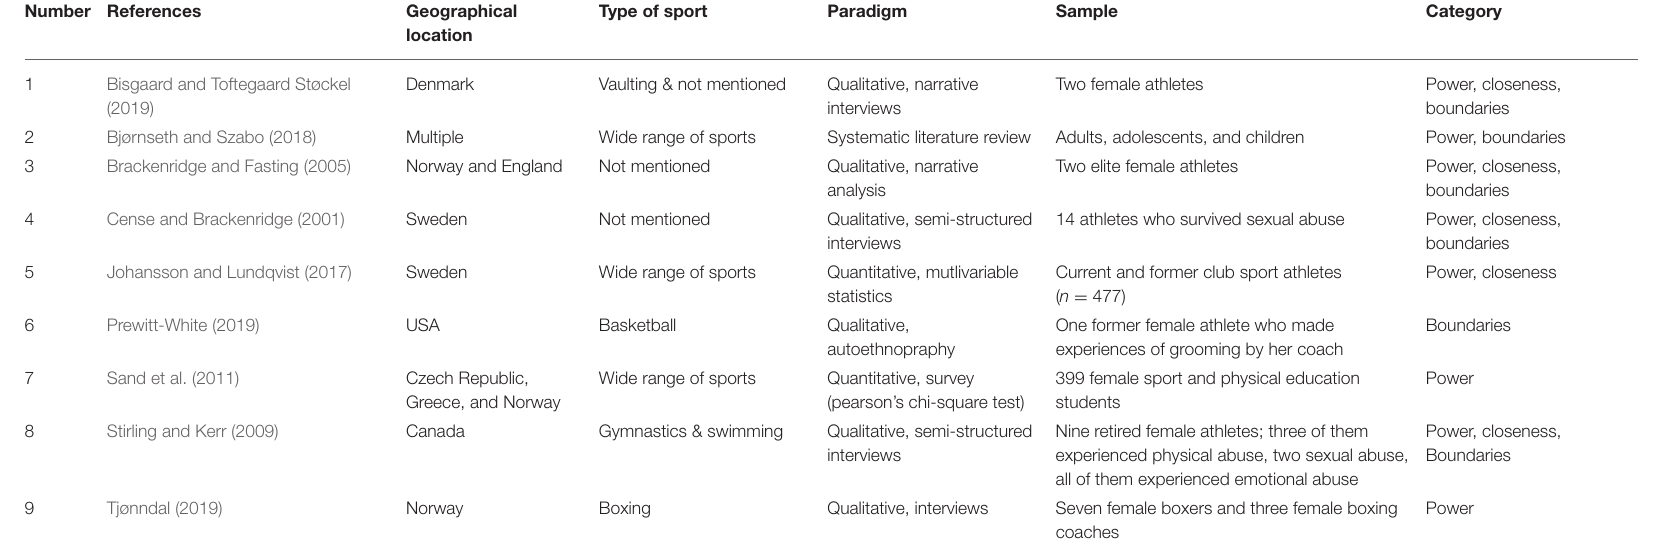
TABLE 3 | Articles with relevance to the psychological